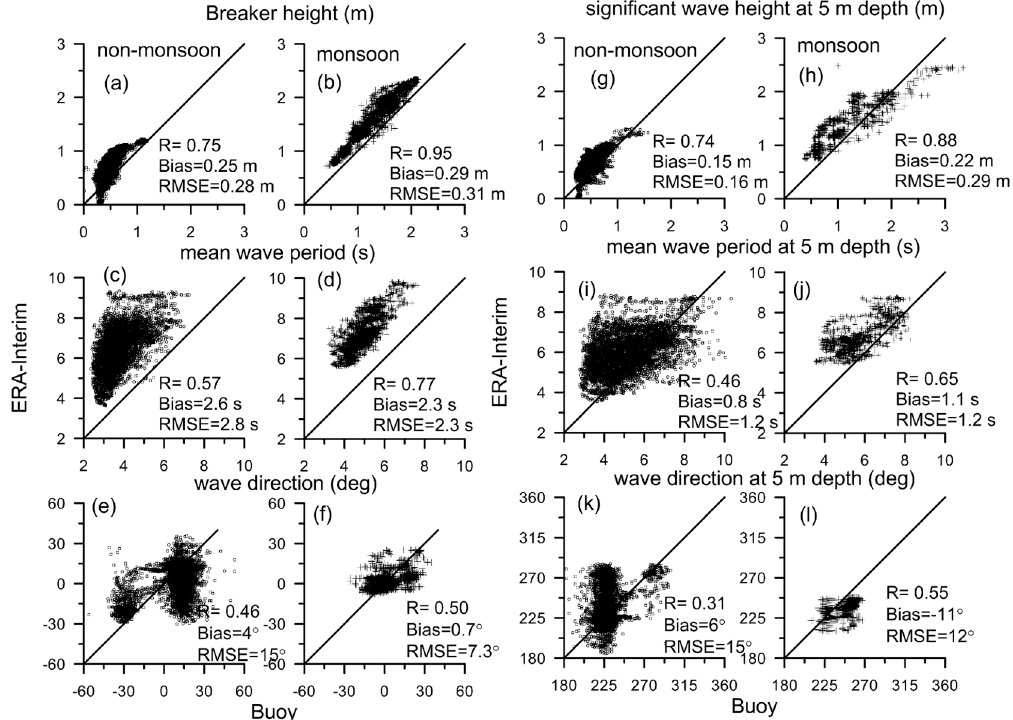
Figure 9. ( a – f ) Scatter plot between the breaker parameters from buoy ‐ measured data and ERA ‐ Interim data. ( g – l ) Scatter plot between buoy ‐ measured data and ERA ‐ Interim data at 5 m water depth. Table 6. Monthly net and gross longshore sediment transport rate using the measured buoy data separated into wind ‐ sea and swell and ERA ‐ Interim data. LSTR Using ERA ‐ Interim Data